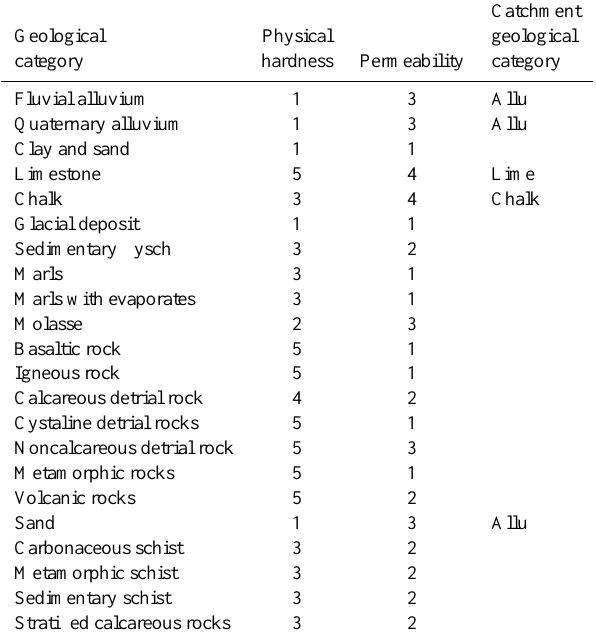
Table 2. Geological categories represented on the 1:1000000 scale geological map of France (BRGM, 1996). Ordinal values of physi- cal hardness range from 1 (soft) to 5 (hard); ordinal values of per- meability range from 1 (impermeable) to 4 (permeable). The fourth column shows the geological categories that were also included in- dependently as environmental variables in our analysis (as propor- tion of the catchment in category). The sum of three categories was used to define alluvium